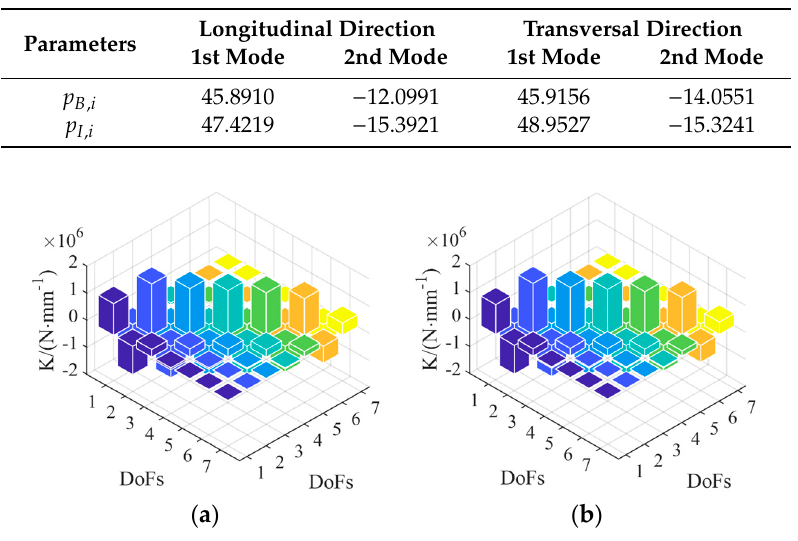
Table 4. Comparisons of the predicted mode participation factors by updated mass matrices.